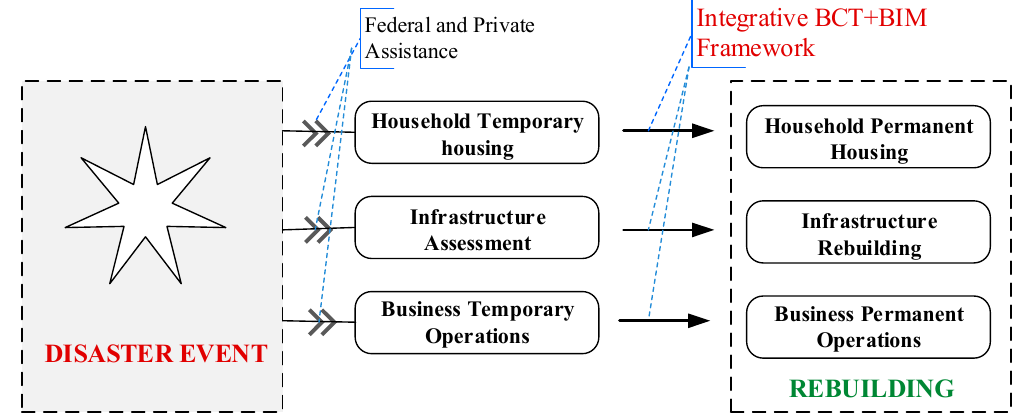
Figure 8. Rebuilding after a disaster and the proposed BCT+BIM framework.